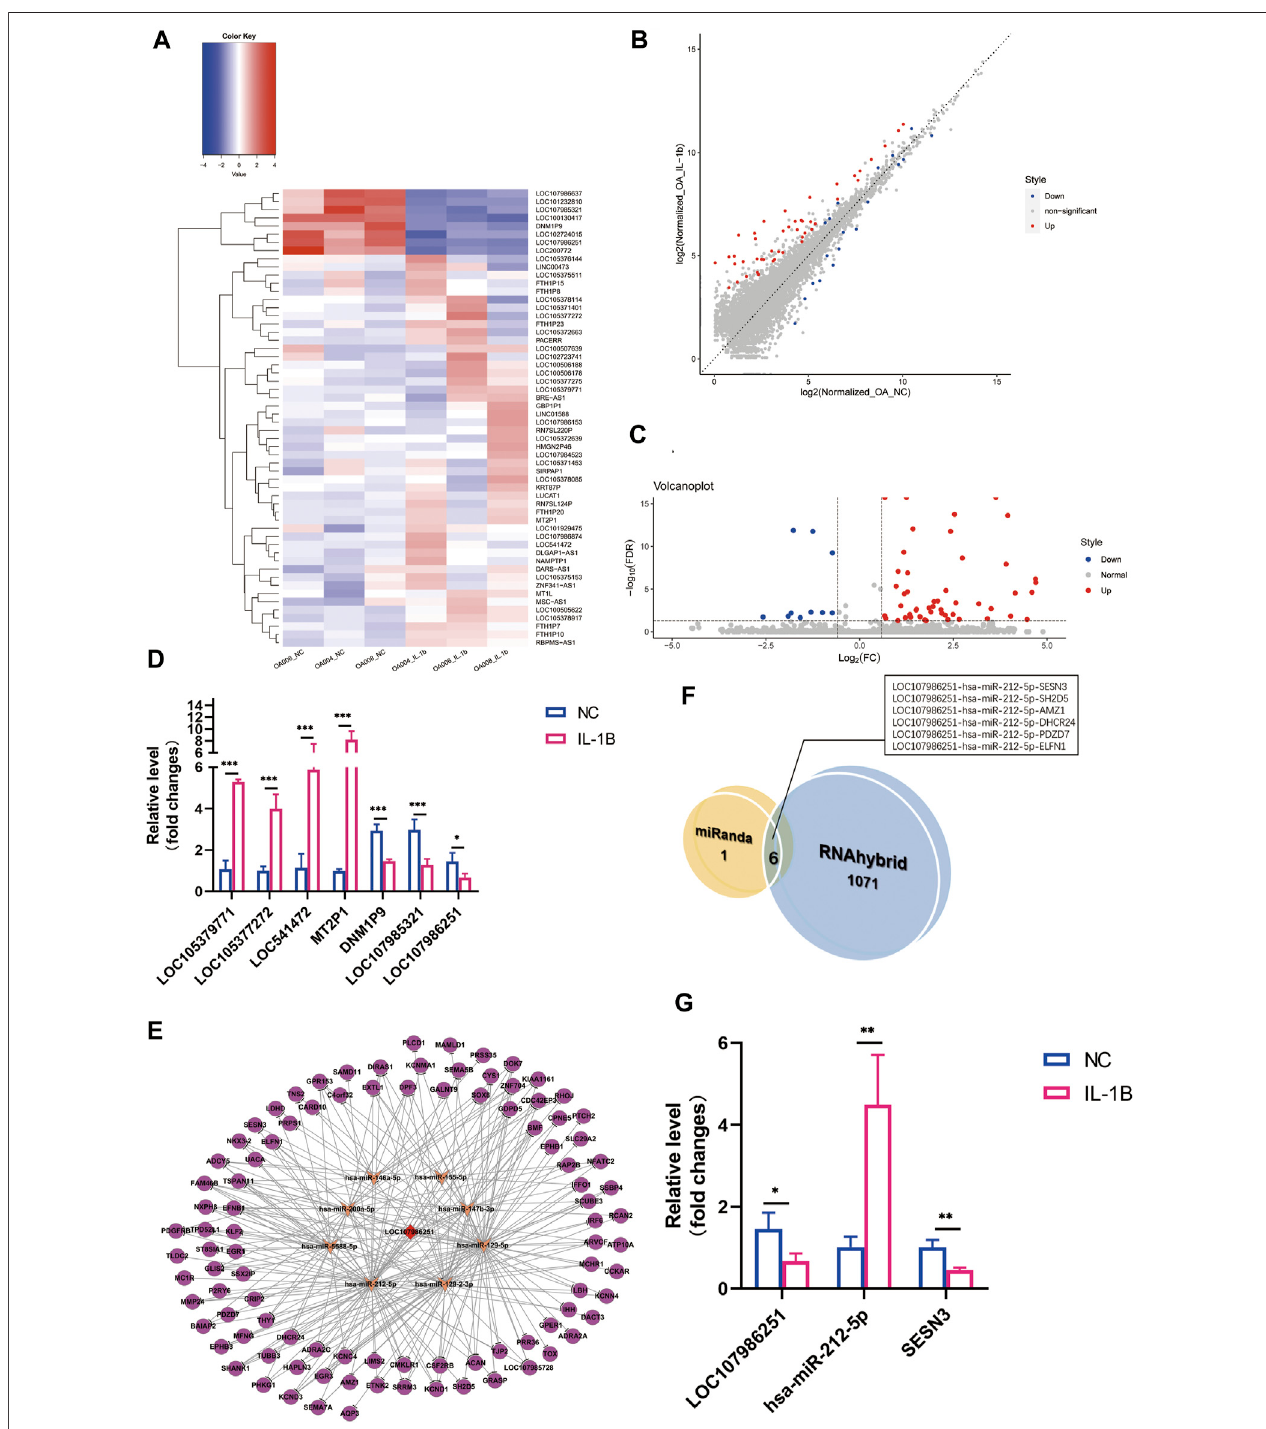
FIGURE 3 | Differential expression pro fi le of long noncoding RNA (lncRNA) and lncRNA LOC107986251 ceRNA network prediction. (A) Hierarchical clustering illustrates distinguished expression difference of lncRNA between the two groups and homogeneity between groups. (B) Volcano plots of differentially expressed lncRNAs. (C) Scatter plots of differentially expressed lncRNAs. (D) Relative expression level of selected lncRNAs in negative control versus IL-1 β -treated osteoarthritis (OA)menisci.GAPDHwasusedastheinternalreferencegeneforqRT-PCRrelativeexpression.Errorbarsrevealthestandarddeviationorthestandarderrorofthe data. The statistical methods are described above. * p < 0.05, ** p < 0.01, *** p < 0.001. (E) LncRNA LOC107986251 network consists of one lncRNA, eight microRNAs (miRNAs),and 97mRNAs(RNAhybrid_Energy < − 25).Thered diamond represents downregulatedlncRNA LOC107986251. Theorangearrows represent upregulated